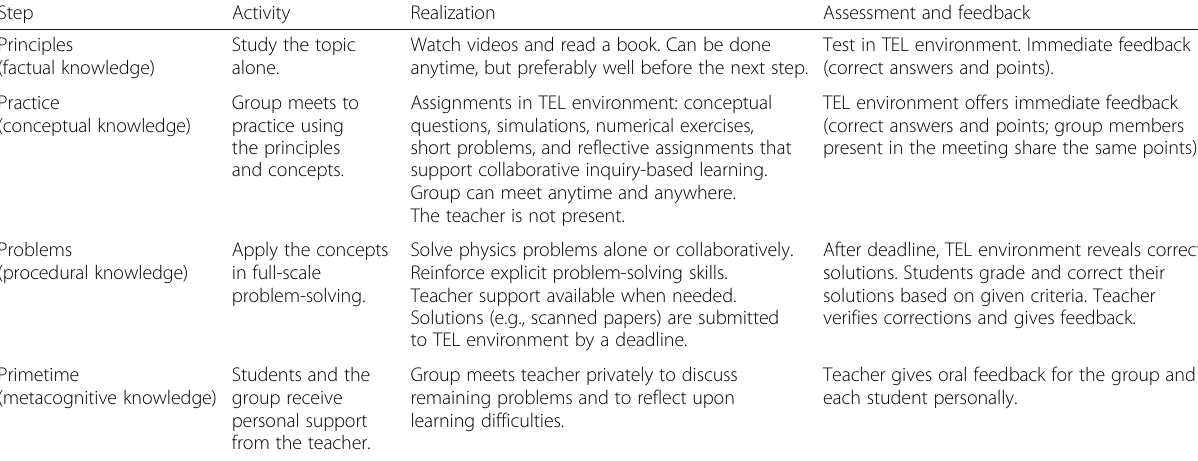
Table 3 The four-step study process of the primetime learning model. The process represents a practical realization of the sketch in Table 2 Step Activity Realization